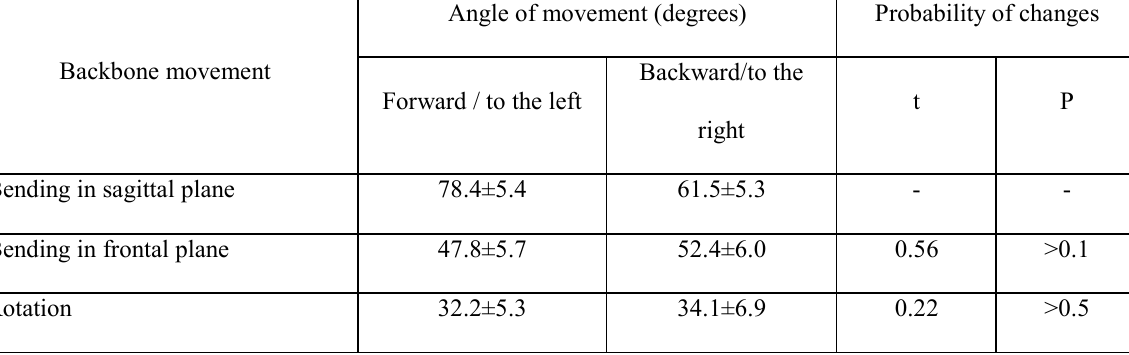
Angles of maximal movements in thoracic and lumbar spines of junior